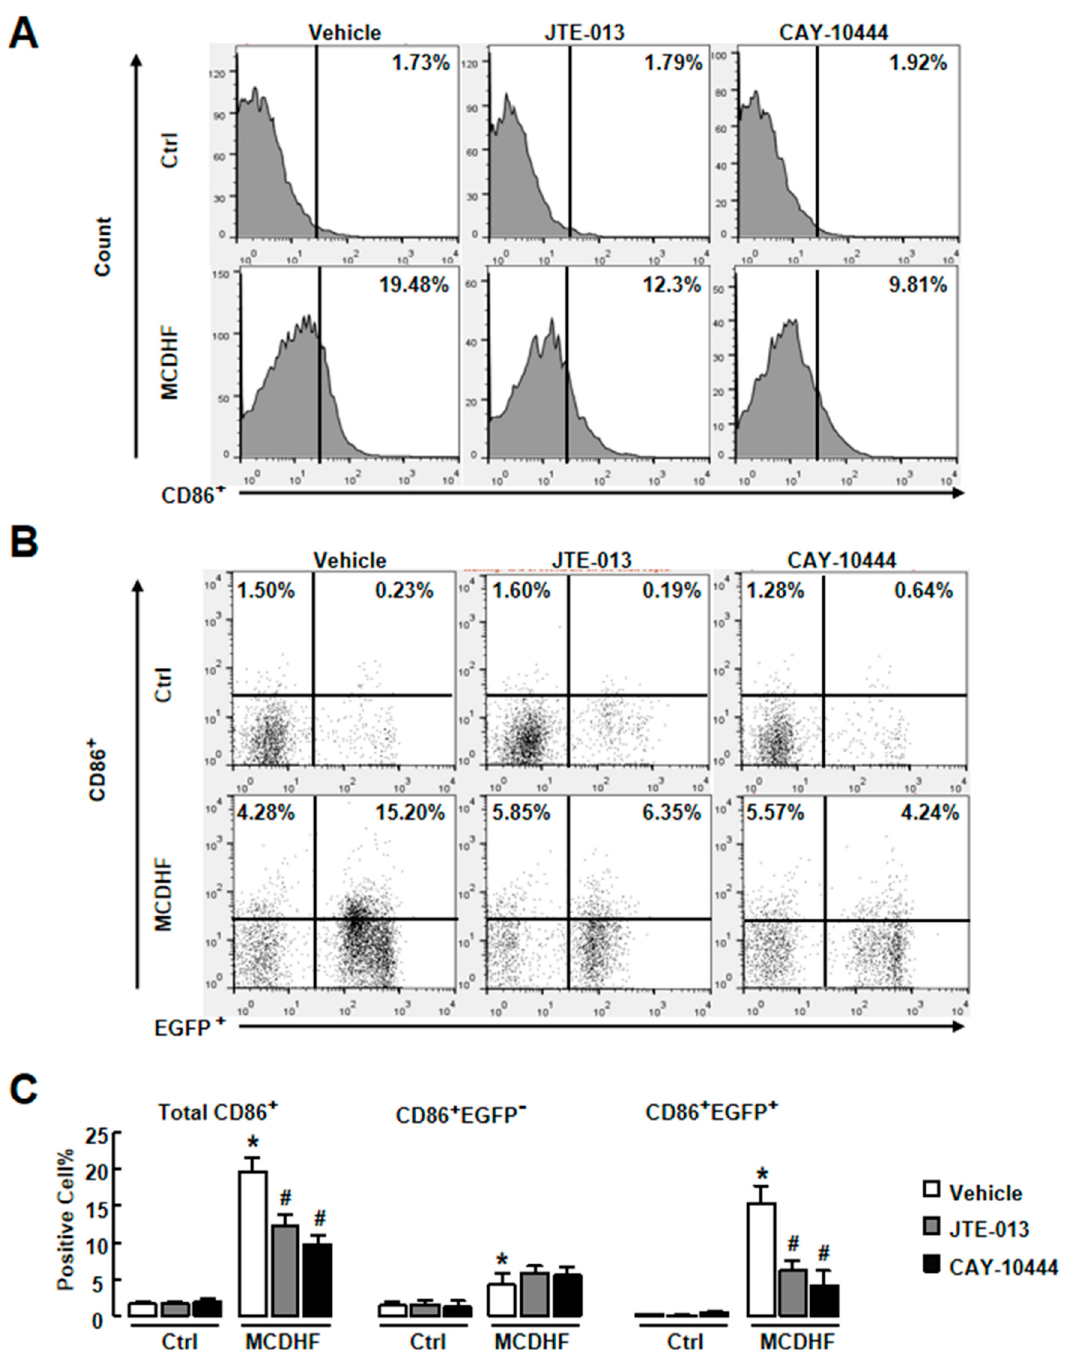
Figure 5. S1PR 2 / 3 antagonist decrease the recruitment of iM ϕ in the liver of MCDHF diet-fed mice. Liver NPCs were isolated from vehicle, JTE-013-treated, and CAY-10444-treated mice after 14 days of control or MCDHF diet feeding. FACS was performed on these cells. ( A ) The percentage of total iM ϕ detected by FACS in the liver. ( B ) The percentage of pro-inflammatory BMMs or pro-inflammatory KCs in the liver. ( C ) Quantification of these cell components. Data are presented as the mean ± SEM. * p < 0.05 versus the group. # p < 0.05 versus the MCDHF diet group ( n = 6 for each group in each experiment).